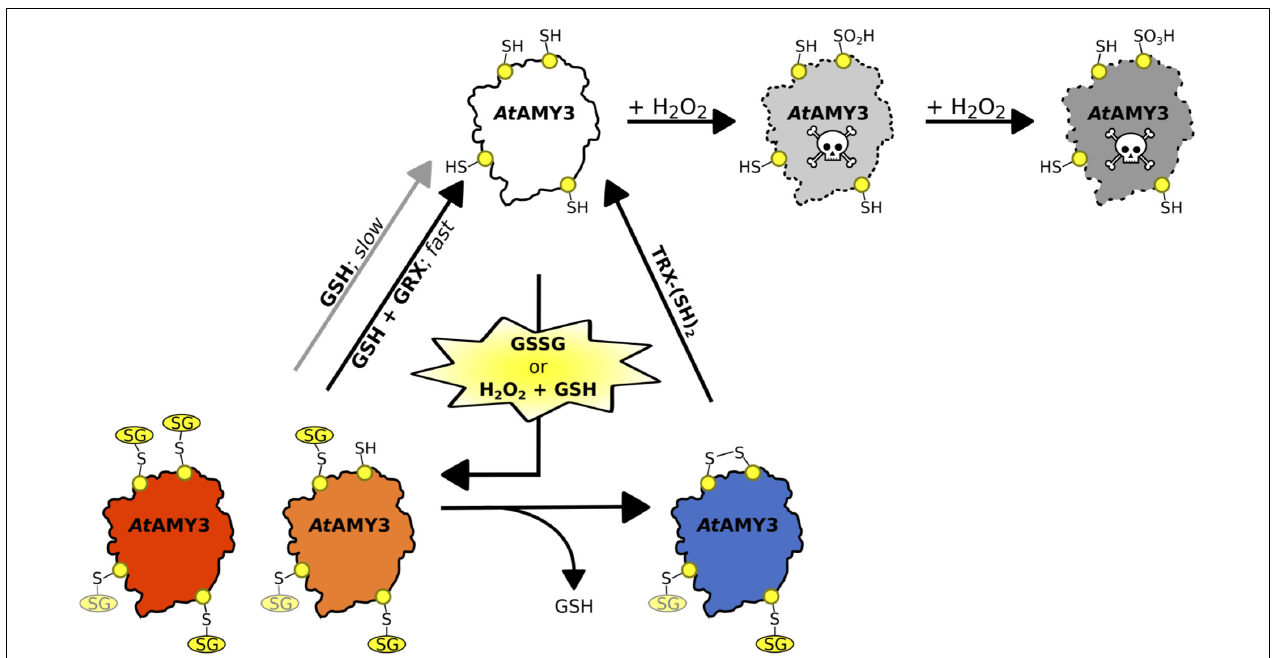
FIGURE 6 | Schematic illustration of the proposed redox-regulatory model of At AMY3 activity. As suggested by DTNB assay, 3.5 cys residues were modified by GSSG; three of them are highlighted in yellow while the fourth is shown in light yellow. In the model, At AMY3 (white) is fully active when reduced (–SH), but it can be irreversibly inactivated when oxidized to sulfinic (pale gray) or sulfonic (gray) acid forms by H 2 O 2 . However, if oxidation occurs in the presence of H 2 O 2 and GSH or is mediated by GSSG, At AMY3 is efficiently protected from overoxidation via S-glutathionylation. S-glutathionylation can lead to a partially (orange) or fully (red) modified enzyme. In case of partial S-glutathionylation (orange), an intramolecular disulfide (blue) can be formed releasing GSH. Thioredoxin (TRX) can activate At AMY3 by reducing this disulfide (white). Similarly, fully glutathionylated At AMY3 (red) can be efficiently activated by GSH through a slow (gray arrow) or a fast (black arrow) process depending on absence or presence of class I glutaredoxin (GRX), respectively.